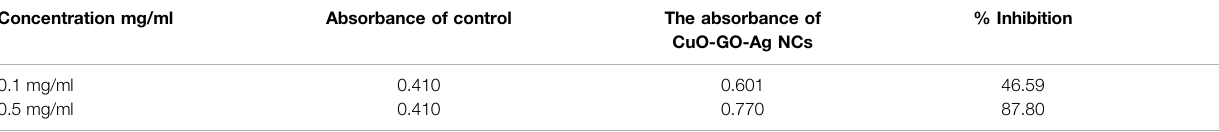
TABLE 2 | % Inhibition and IC 50 of CuO-GO-Ag NCs.